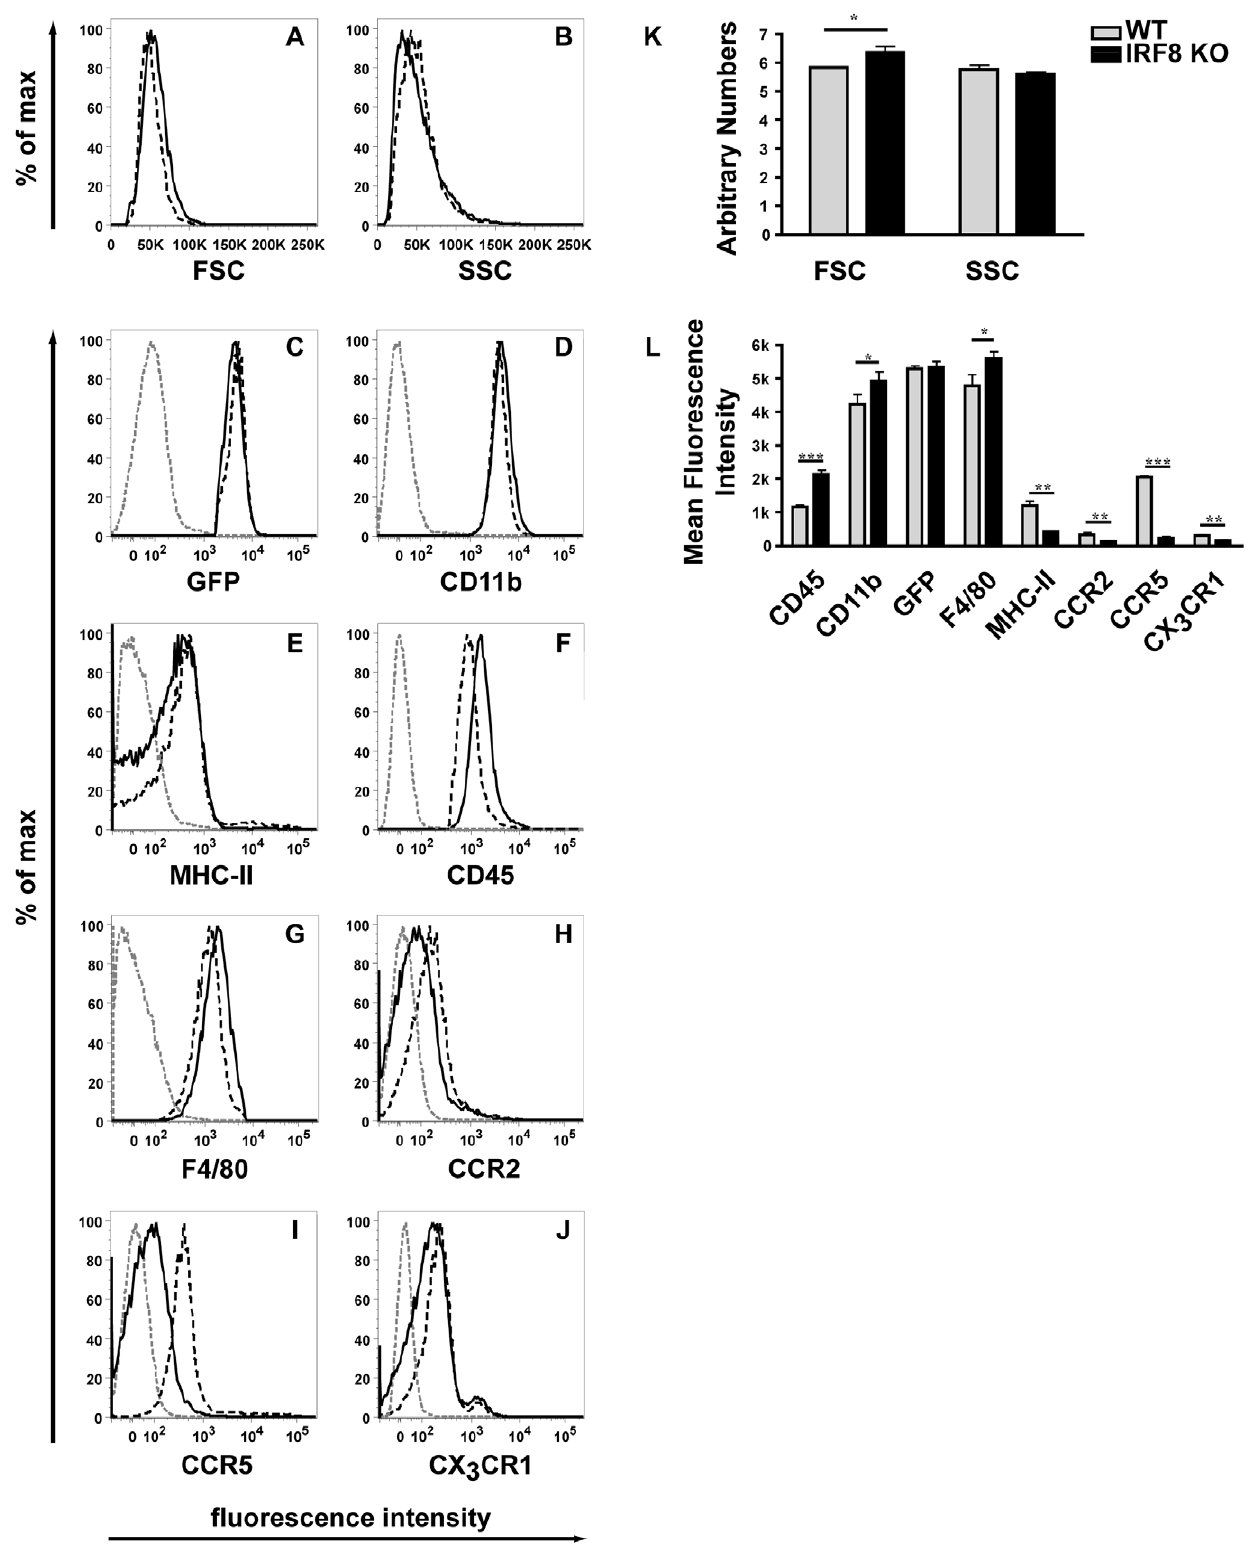
Figure 4. GFP + cells in the CNS are exclusively CD11b + microglia. Flow cytometry was performed on cells isolated from the brain of healthy adult WT (A, B) and IRF8-deficient mice as described in the Materials and Methods. For analysis, cells were scatter-gated to exclude dead cells and GFP + cells were selected (A). Greater than 99% of GFP + cells expressed CD11b in WT and IRF8-deficient mice (B), consistent with a microglial phenotype. Isotype matched antibodies were used to determine background staining (data not shown).